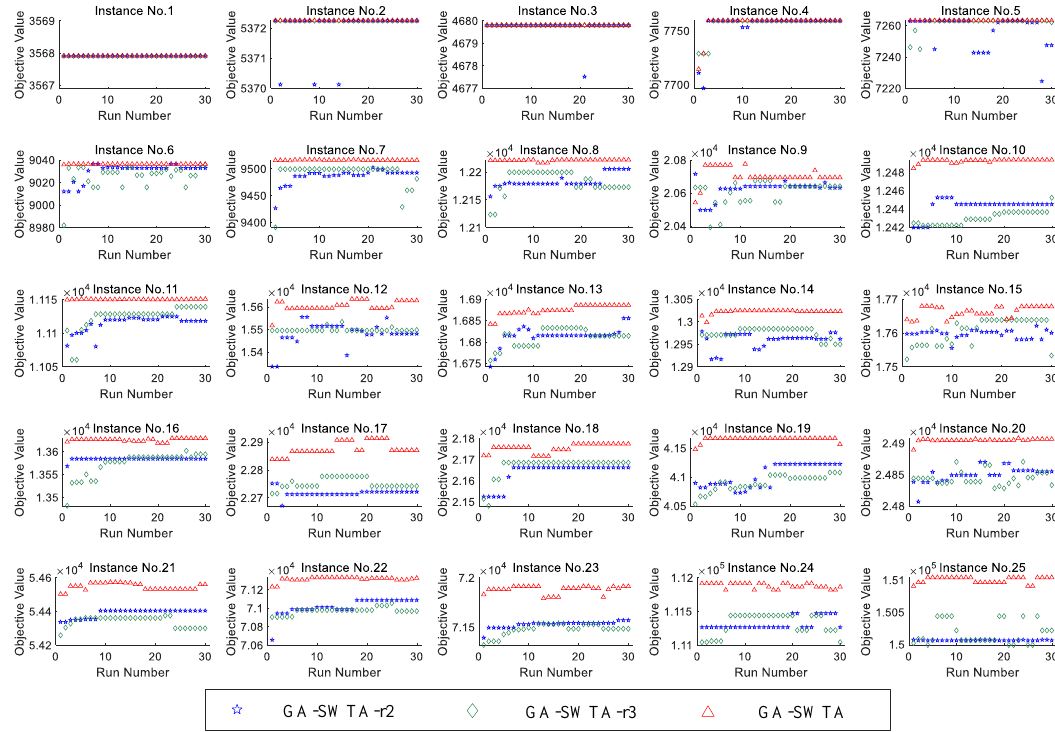
Figure 14. Comparison results of GA-SWTA-r2, GA-SWTA-r3, and GA-SWTA with respect to the objective